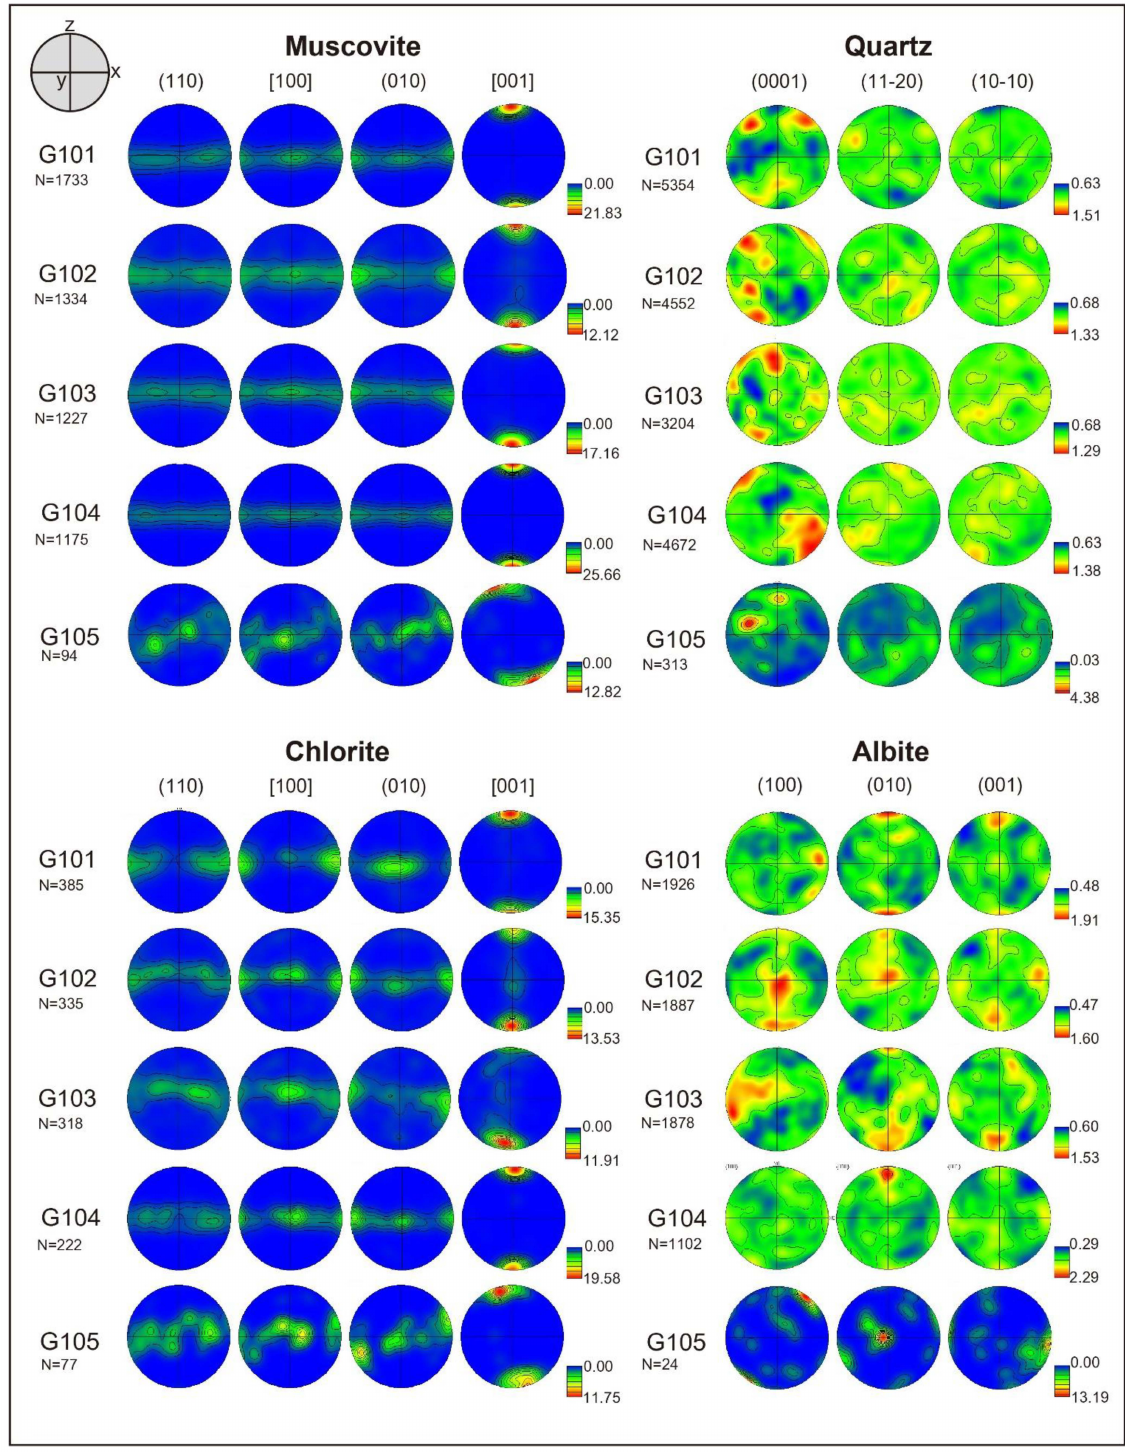
Figure 5. Pole figures of the quartz, muscovite, albite, and chlorite presented in the lower hemisphere using equal-area projection. A half-scatter width of 20 ◦ was used. The color coding indicates the data point density. Multiples of uniform distribution are denoted as the numbers in the legend. E–W direction of each figure corresponds to stretching lineation (X), and N–S direction (Z) is perpendicular to the foliation. N = number of data